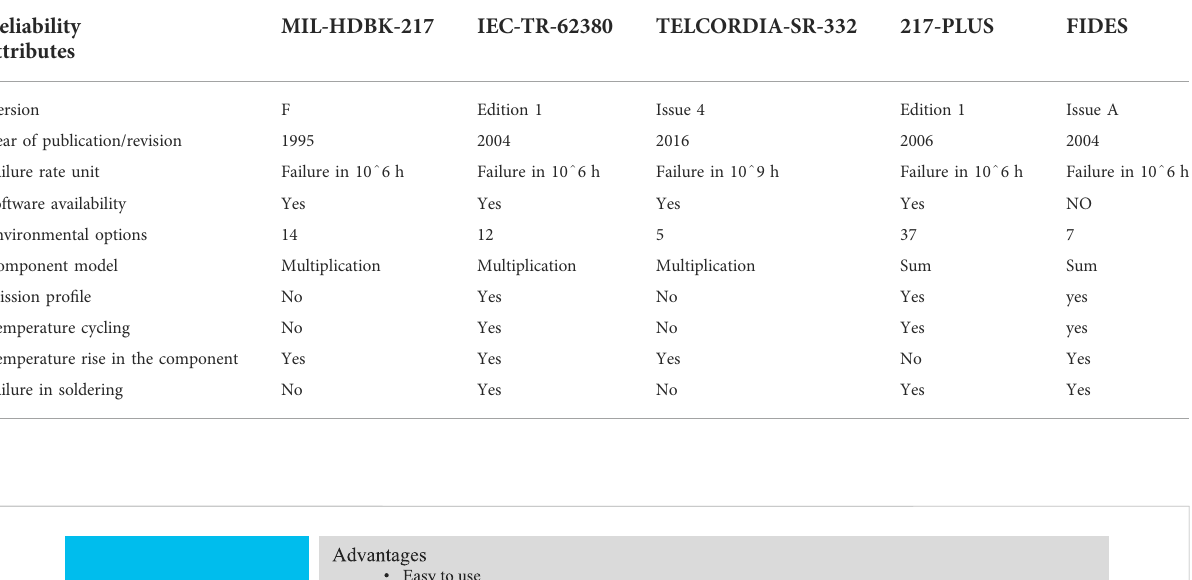
TABLE 1 Qualitative and quantitative comparison of reliability methods.